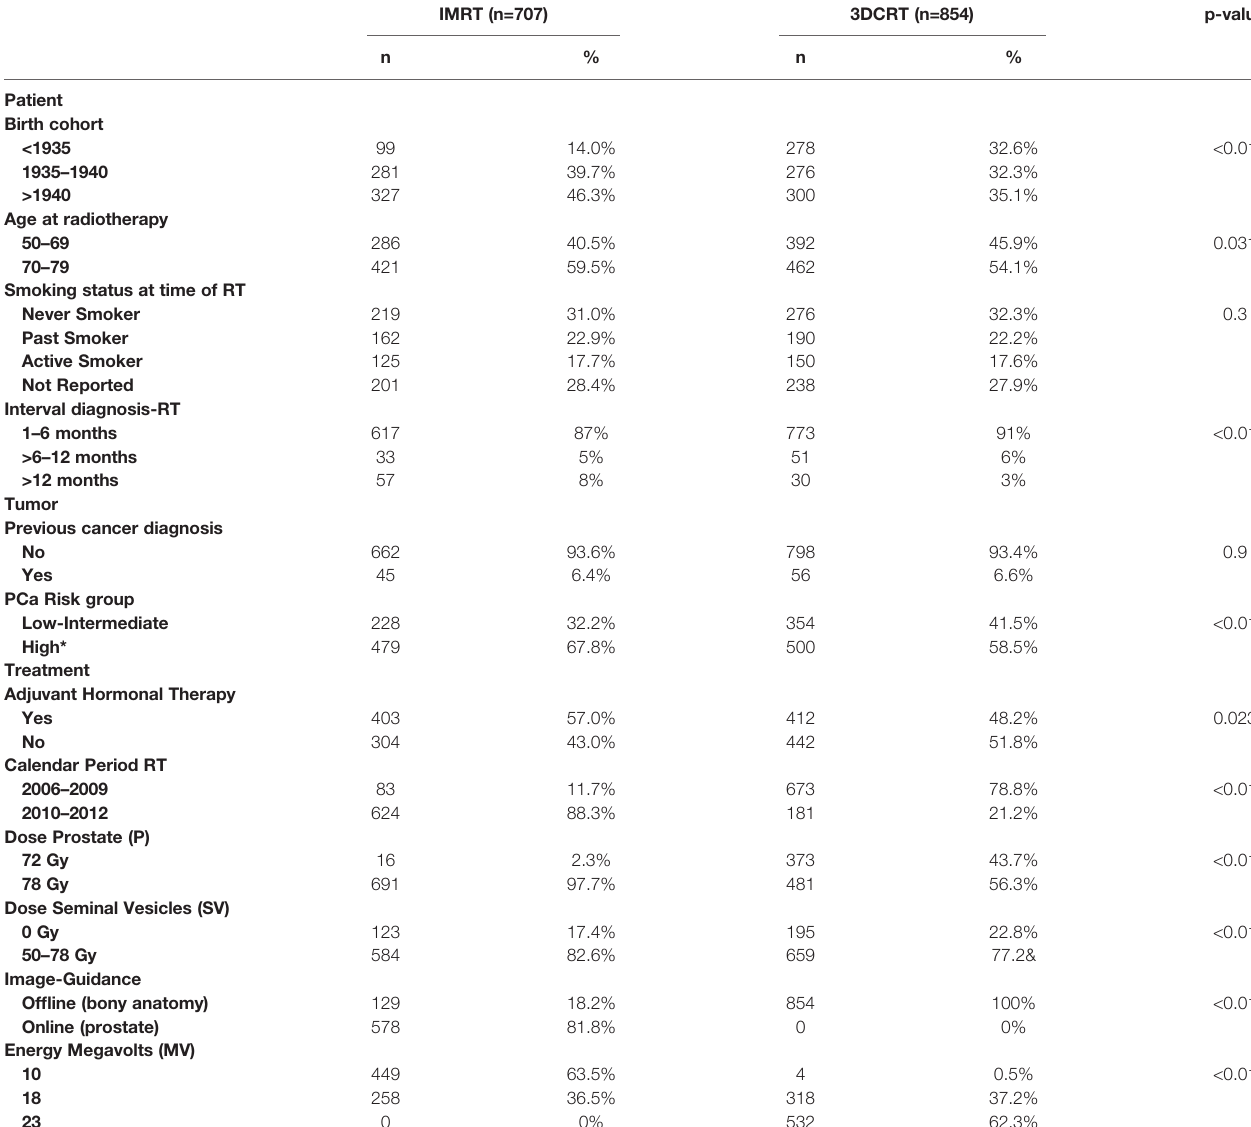
TABLE 1 | Baseline Characteristics of the IMRT and 3DCRT PCa patient cohort